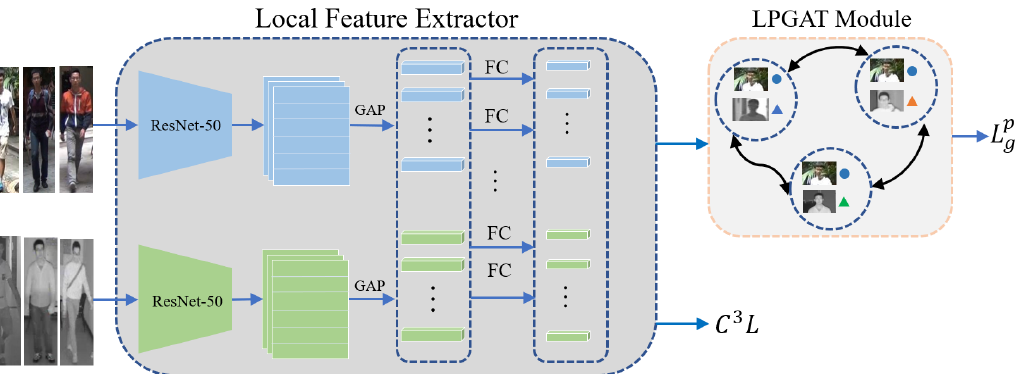
Figure 2. The framework of our approach. We first apply the Local Feature Extractor to obtain the local features from different modalities. Then, we propose the LPGAT module to learn the correlation between the paired local features from different modalities. The same color indicates the same pedestrian, and the circle and the triangle represent IR and RGB modalities, respectively. We also use the proposed C 3 L to optimize the network, which constrains the distance between the local features and their heterogeneous